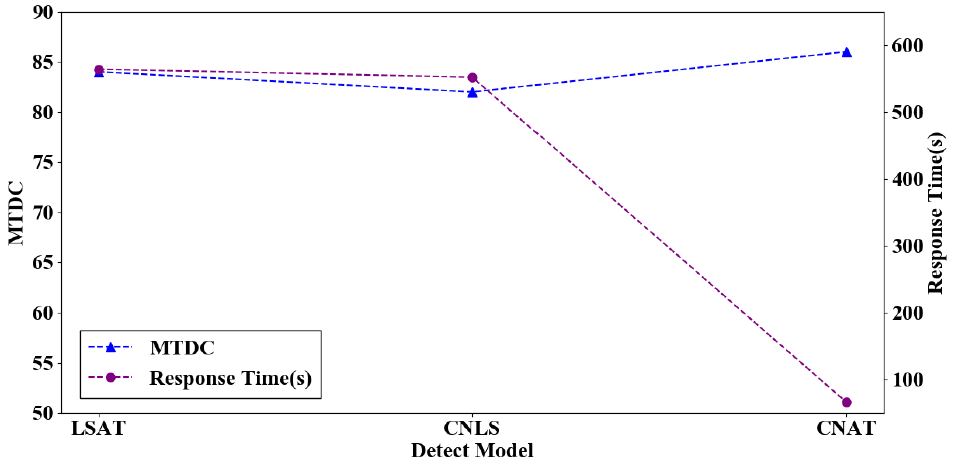
Figure 10. The different model performance.